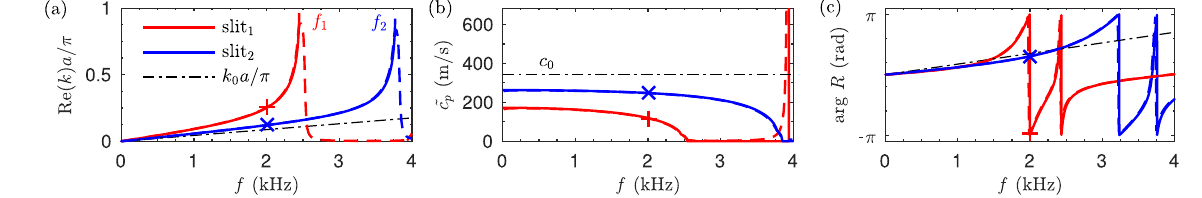
Figure 2. ( a ) Dispersion relation inside the (blue) first and (red) second slits of a metadiffuser for the lossless case (continuous lines) and accounting for the thermo-viscous losses (dashed lines), and wavenumber in air (dashed-dotted). The resonance frequencies of the HR are shown as f 1 and f 2 . ( b ) Corresponding phase speed. ( c ) Phase of the reflection coefficient for each individual slit.